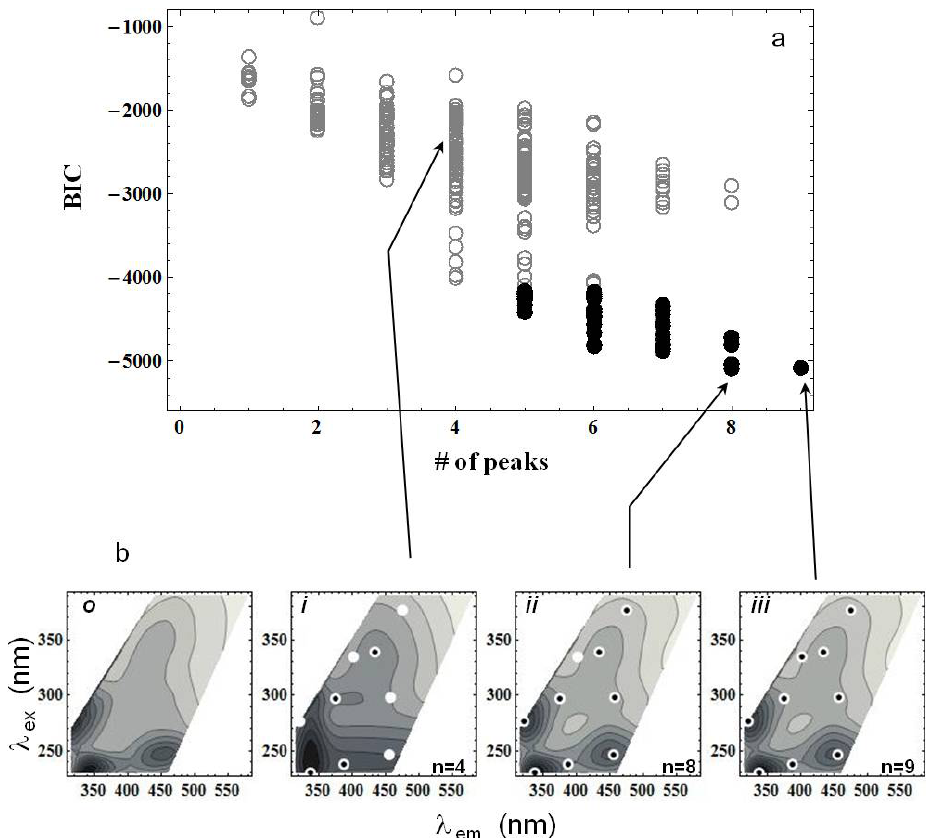
Fig. 3. Visual example of the optimal model selection process. This example refers to the sample S17 with nine potential peaks ( n = 9). (a) shows the relationship between BIC values and number of peaks obtained executing the FDM z (x,y) (Eqs. 1 and 2) for all possible subsets i of the nine potential peaks, where i = 2 9 − 1 = 511. Gray disks and black dots discern modelled EEM adjust with r 2 lower and higher than 0.99, respectively. (b) shows the contour plots of original EEM sample ( o ), and three model outputs with a “poor” adjust (i), “optimal” adjust (i.e., lower BIC values, (ii) and overfitted adjust (i.e., larger number of peaks, (iii). Large white and small black dots in contours plots show location of potential and selected peaks, respectively. Each contours represents 10% of total